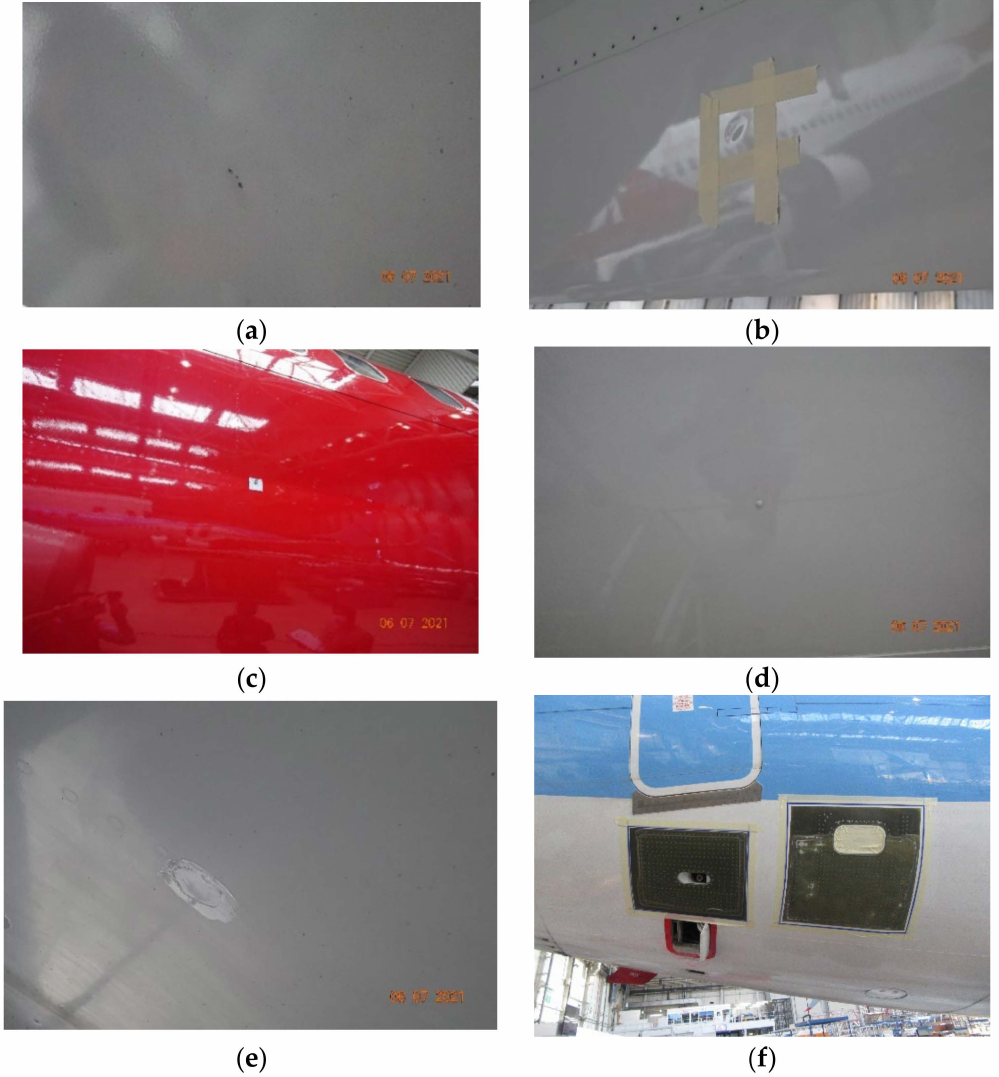
Figure 1. Images of different types of defects in aircraft structures. ( a ) Missing paint, ( b ) dents, ( c ) lighting strike damage, ( d ) lighting strike fastener repair, ( e ) blend/rework repair (material removed and then re-protected with exterior paint); ( f ) double patch